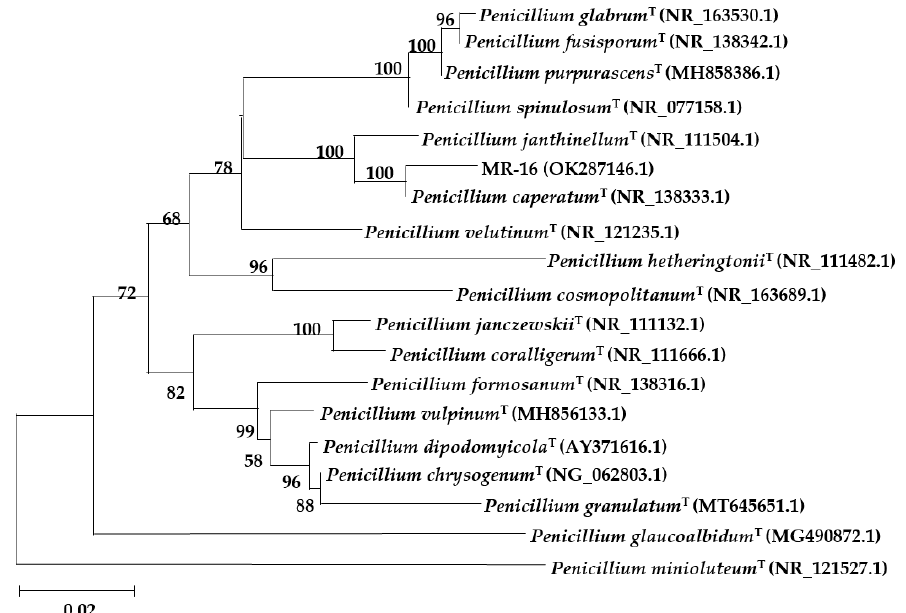
Figure 3. Phylogenetic analysis of MR-16 and its relatives based on the nucleotide sequences of ITS sequences by using the neighbor-joining method (NJ). The values of significant bootstrap (>58%) and the scale (0.02) of the phylogenetic tree are exhibited.